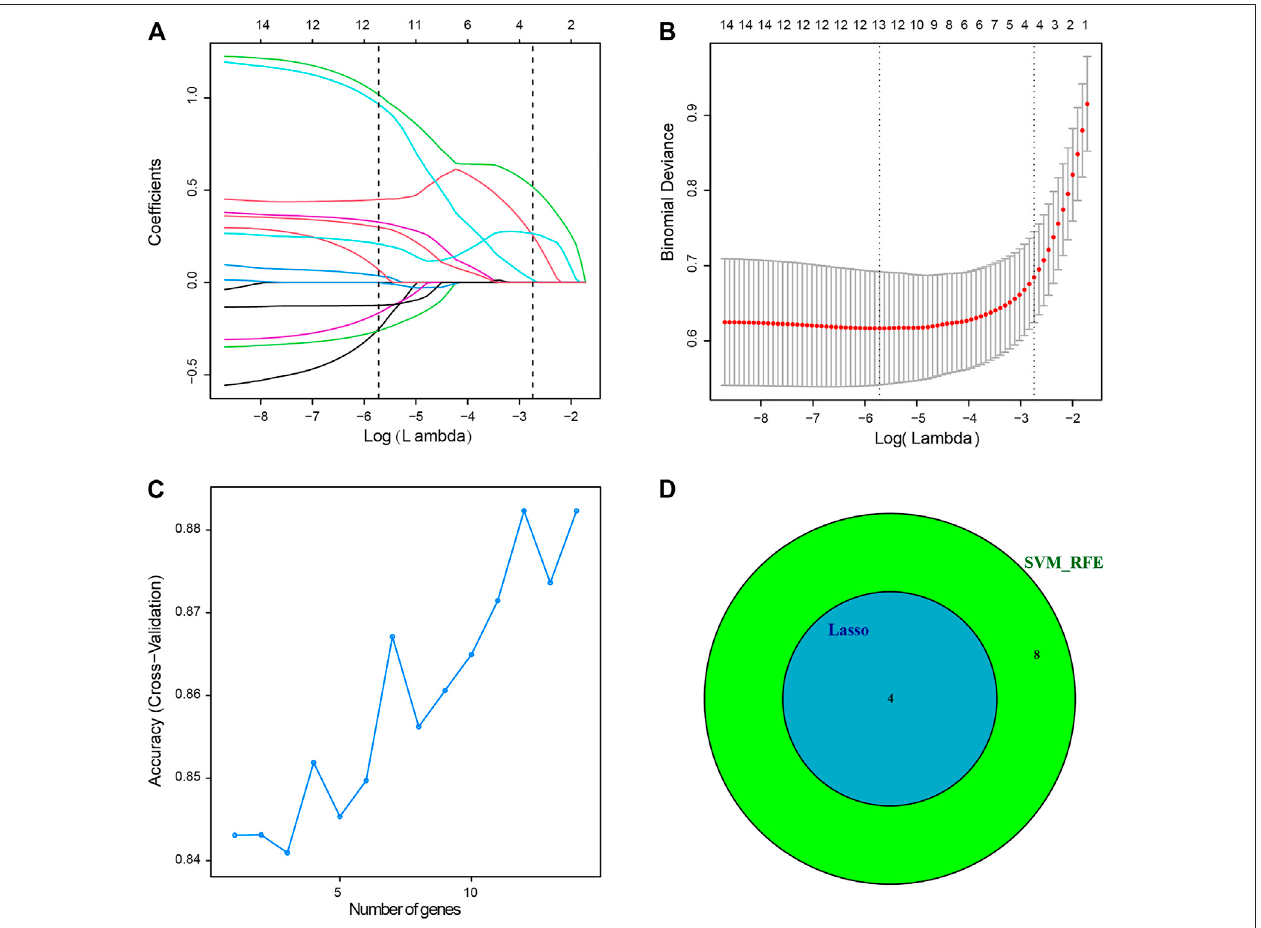
FIGURE 4 | Two algorithms were used for diagnostic markers for selection. (A) Least absolute shrinkage and selection operator (Lasso) algorithm to screen diagnostic markers, 10-fold cross-validation for selection in the Lasso model. Different colors represent different genes. (B) Lasso coef fi cient pro fi les of 14 immune- related DEGs. (C) The accuracy of the estimate generation for the support vector machine-recursive feature elimination (SVM-RFE) algorithm. (D) The individual feature selection by Lasso and SVM-RFE algorithms and the intersection of diagnostic markers obtained by the two algorithms.